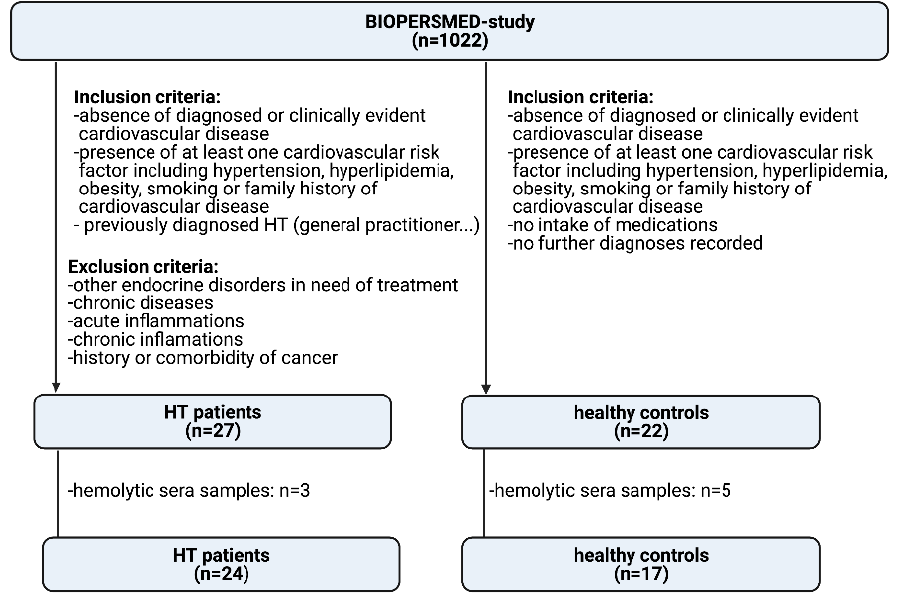
Figure 1. Study flow chart.